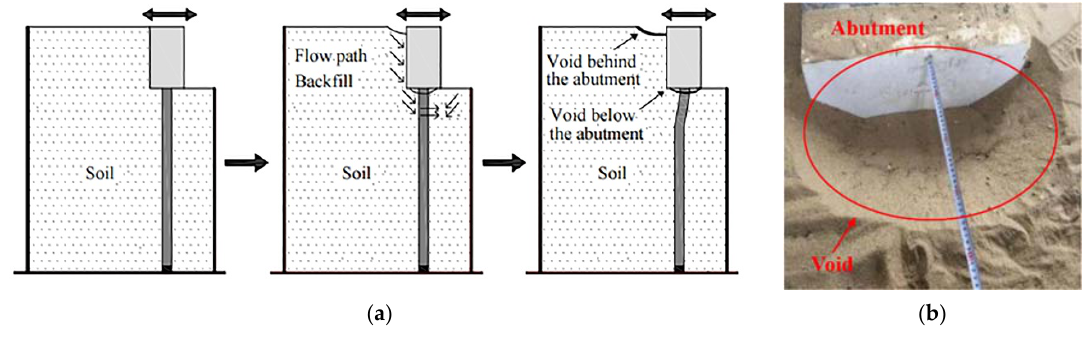
Figure 22. Void formation. ( a ) Process of void formation. ( b ) Void behind the abutment. Horizontal Deformation under Negative Displacements